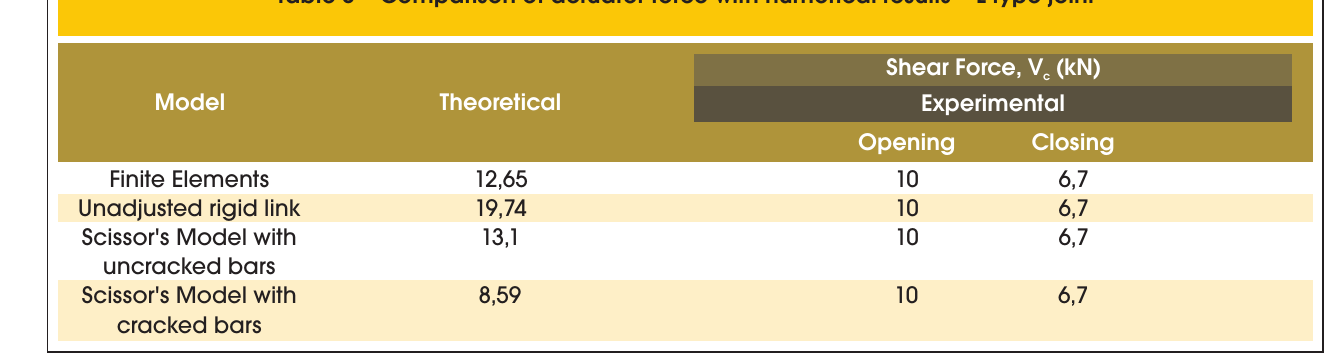
Table 3 – Comparison of actuator force with numerical results – L-type joint